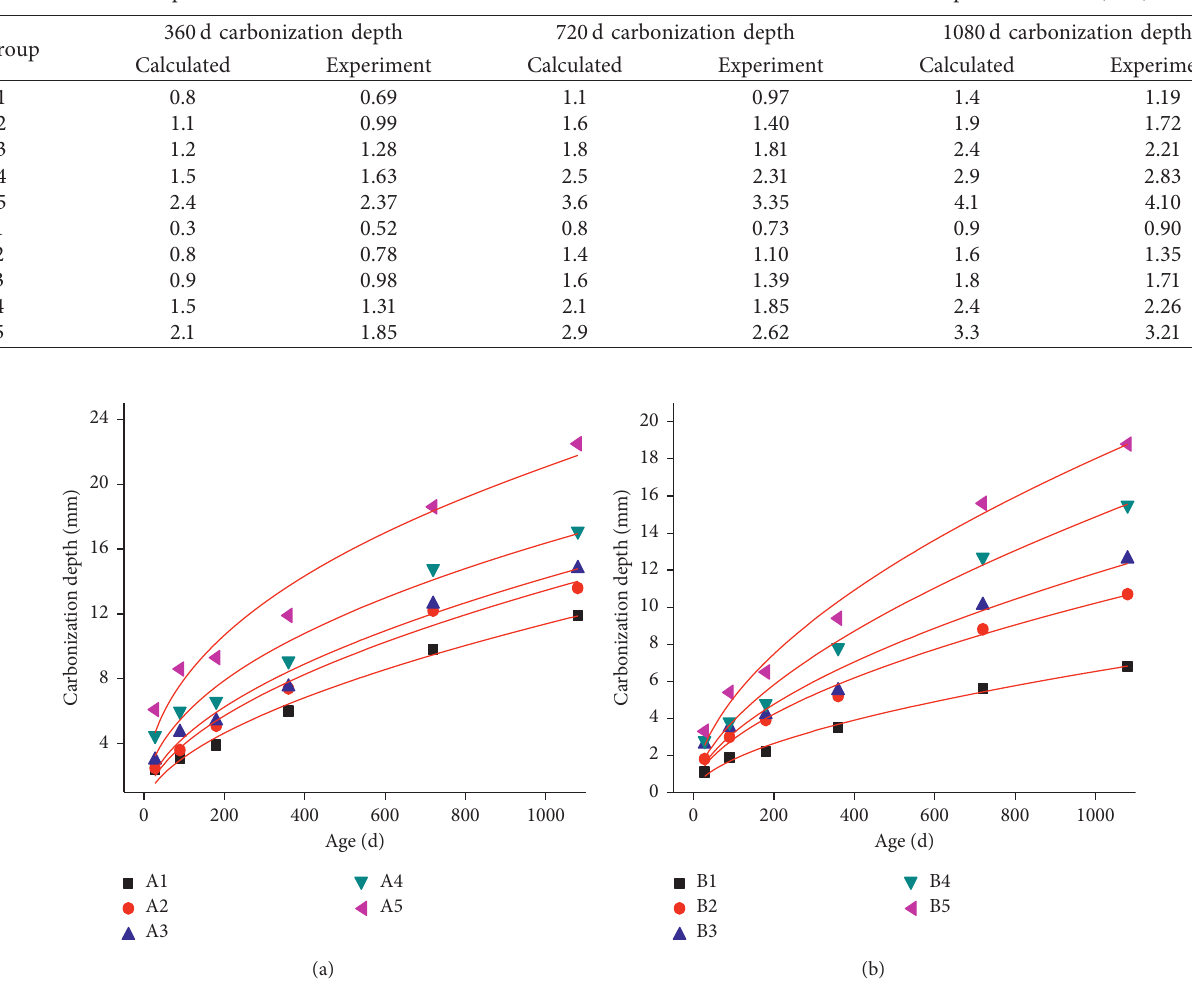
Figure 5: Natural carbonation depth of iron tailings powder concrete after 1 d curing. (a) C30. (b) C50. Table 7: Time-carbonation depth fitting equation for iron tailings